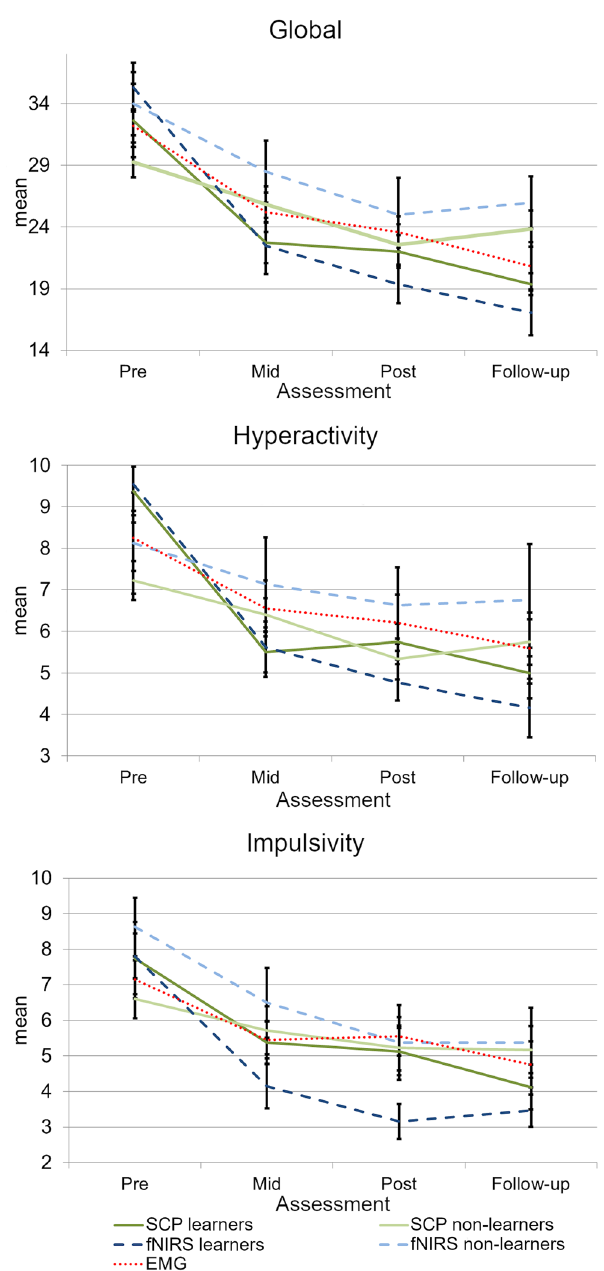
Figure 5. ADHD self-rating differentiating learners from non-learners in fNIRS- and SCP-NF compared to